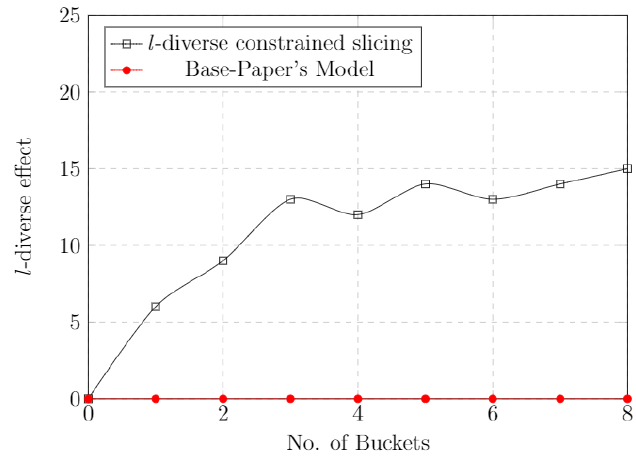
Figure 7. l -Diverse effect—comparison with base paper.